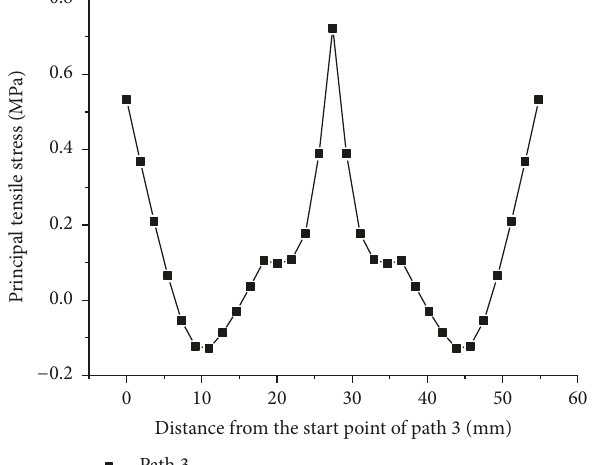
Figure 35: Principal tensile stress in the concrete specimen prestressed under a load of 10 MPa when the displacement resulting from corrosion-induced expansion reaches 0.031 mm.